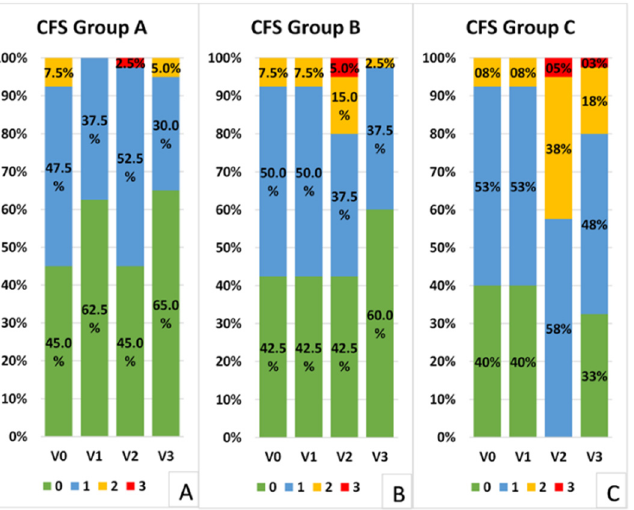
Figure 3. Corneal fluorescein staining (CFS, Oxford scale) distribution in the three groups: ( A ) Group A; ( B ) Group B; ( C ) Group